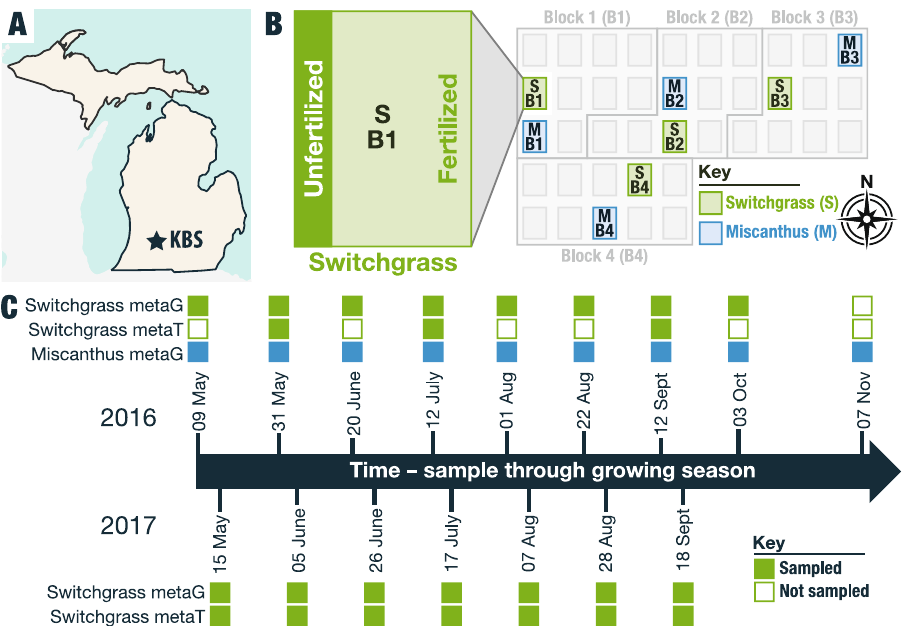
Fig. 1 | Phyllosphere microbiome fi eld sampling strategy at the Great Lakes